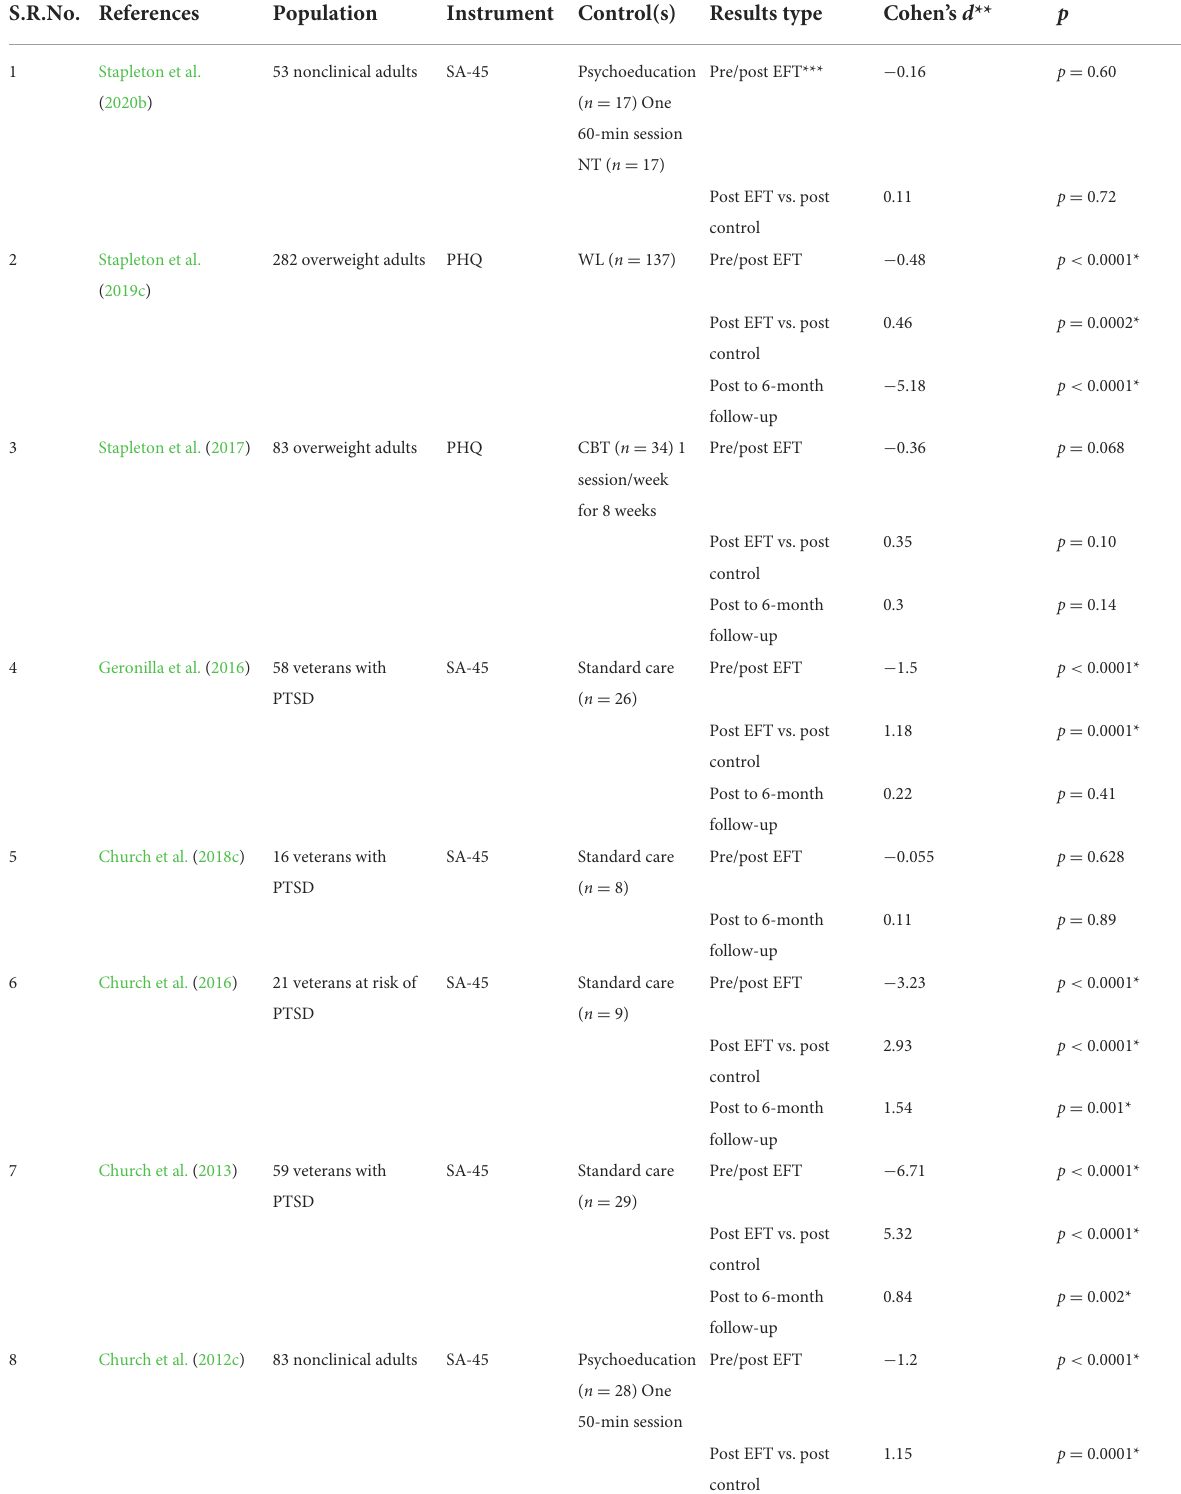
TABLE 9 Somatization RCTs included in the Stapleton et al. (2021)